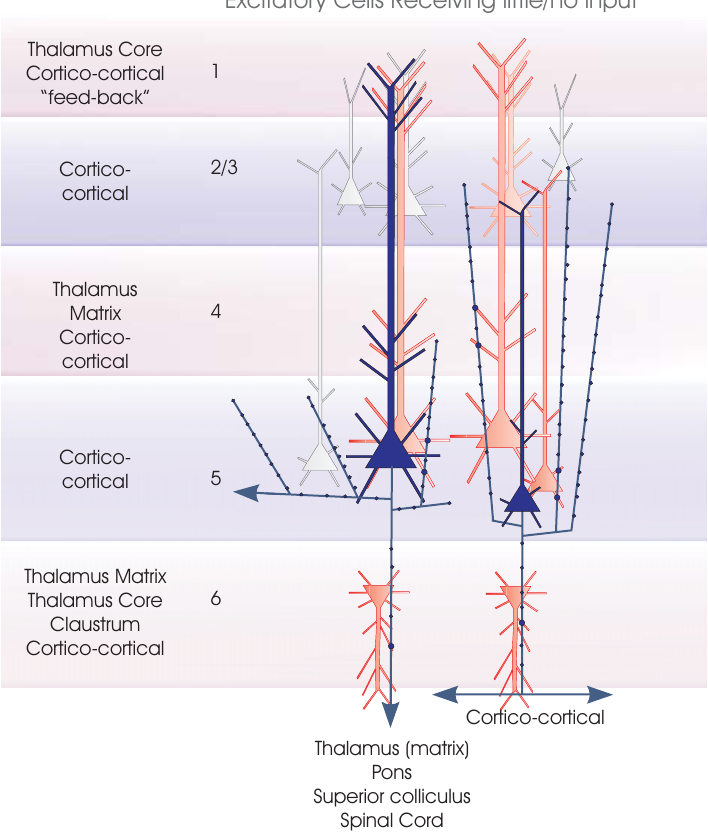
Figure 2. Layer 5 pyramidal cells . The two major subclasses of layer 5 pyramidal cells are summarized in this cartoon (blue). Large pyramids with a pronounced apical dendritic tuft in layers 1 and 2 project to several subcortical regions, while small, shorter pyramids include CC cells. The major inputs to each layer are indicated to the left. Spiny, excitatory postsynaptic targets that have been demonstrated with paired intracellular recordings are shown in red, the paler cells being those that receive sparse and weak inputs and the white cells those that have been tested but not to date shown to be significant targets for these axons. Where a class of spiny excitatory cell is not indicated in a particular layer, it has not been tested sufficiently often with layer 5 pyramidal cells in paired recordings to determine whether the connection